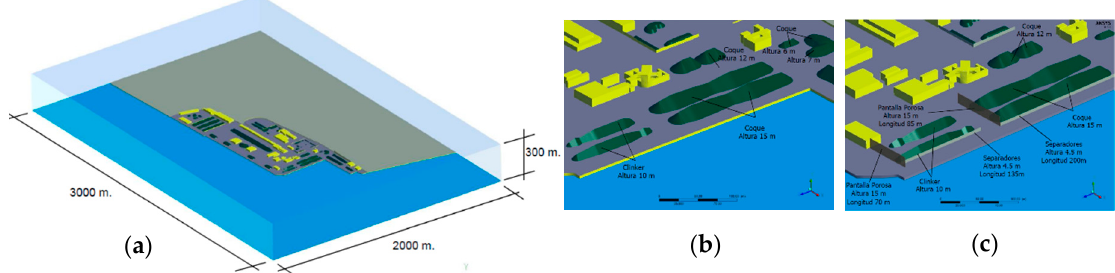
Figure 2. ( a ) Characteristics of the control volume aim of study; ( b ) Initial situation; ( c ) Finally, with wind fences.